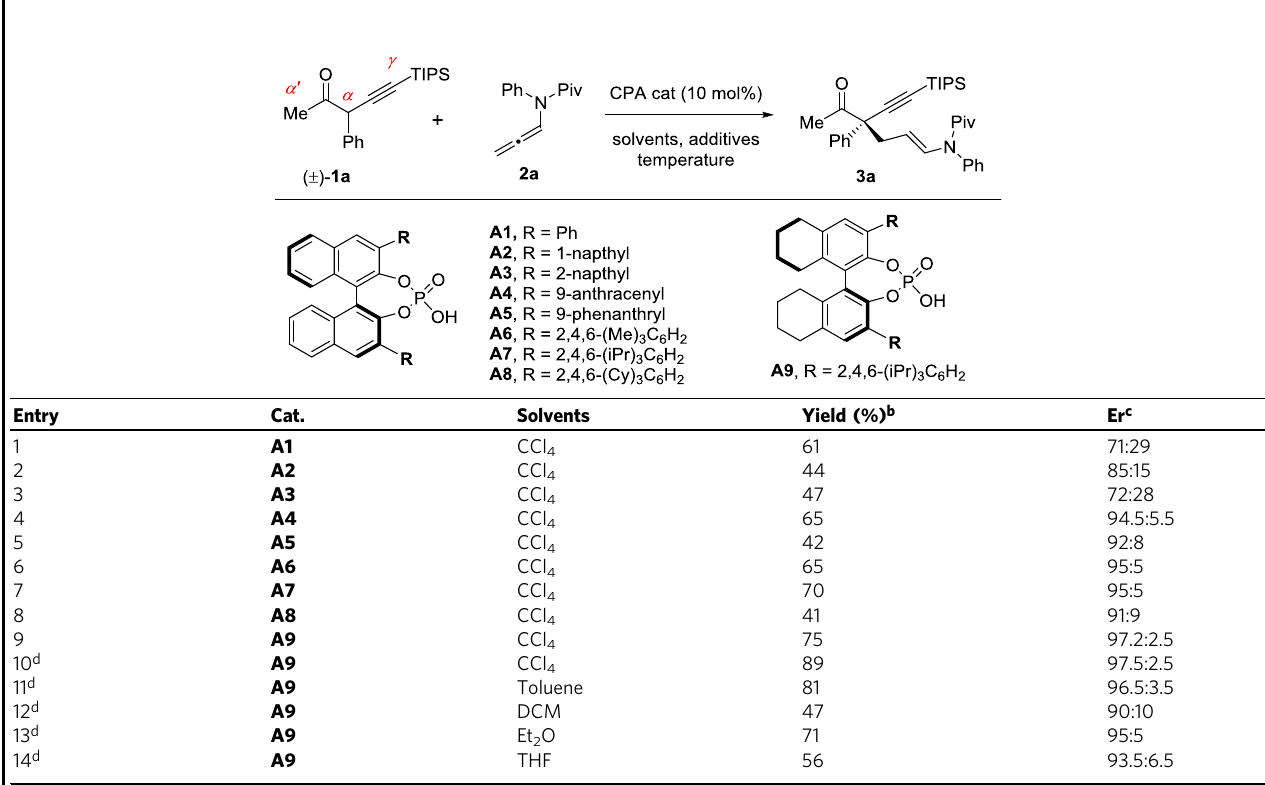
Table 1. Optimizations of the reaction conditions a